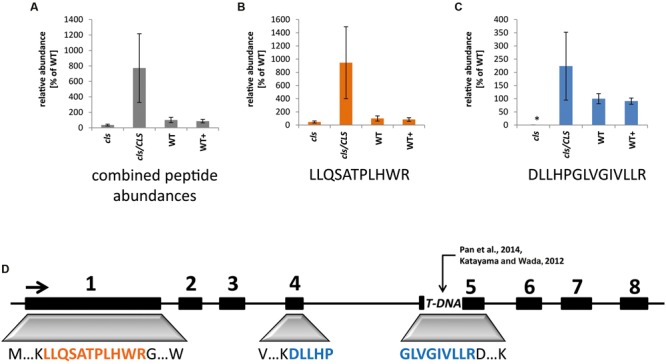
Quantitation of cardiolipin synthase by means of tSIM-MS.
(A) Combined average peak areas for two peptides of At4g04870 (LLQSATPLHWR, DLLHPGLVGIVLLR) in arbitrary units (WT = 100%) for cls, cls/CLS, WT, and WT+. (B) Average peak areas for LLQSATPLHWR. (C) Average peak areas for DLLHPGLVGIVLLR. Error bars indicate standard error of three biological replicates, asterisk indicates p < 0.05 when compared to WT. (D) Position of analyzed peptides within the exon/intron structure of the CLS gene. Boxes indicate exons, lines indicate non-coding regions. TDNA indicates TDNA insertion according to Katayama and Wada (2012) and Pan et al. (2014).